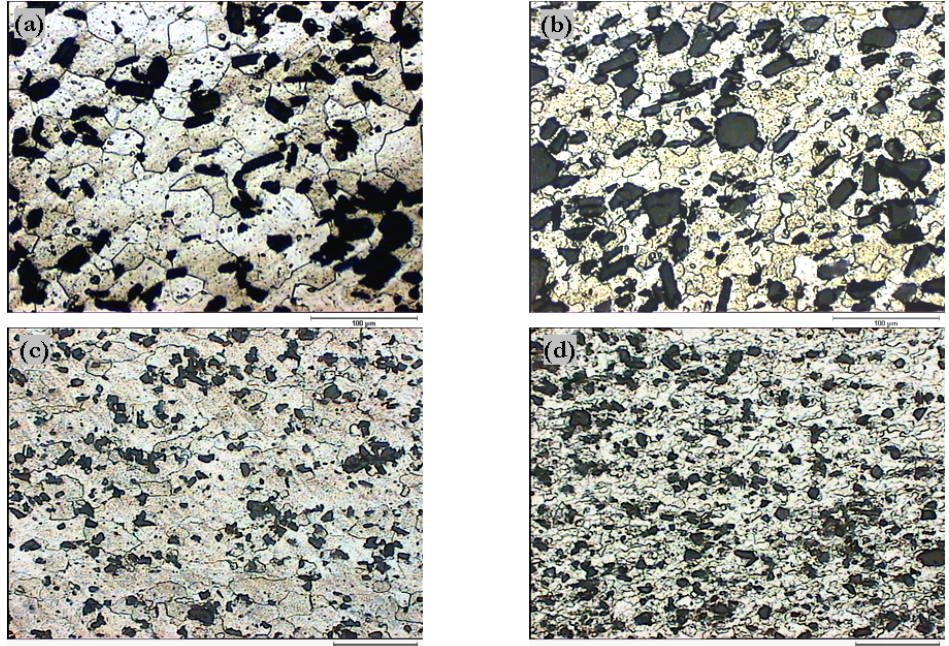
Figura 7: Effetto della FSW sulla dimensione dei grani della matrice di alluminio, per W6A20A: (a) materiale base e (b) nugget ; per W7A10A: (c) materiale base e (d) nugget.